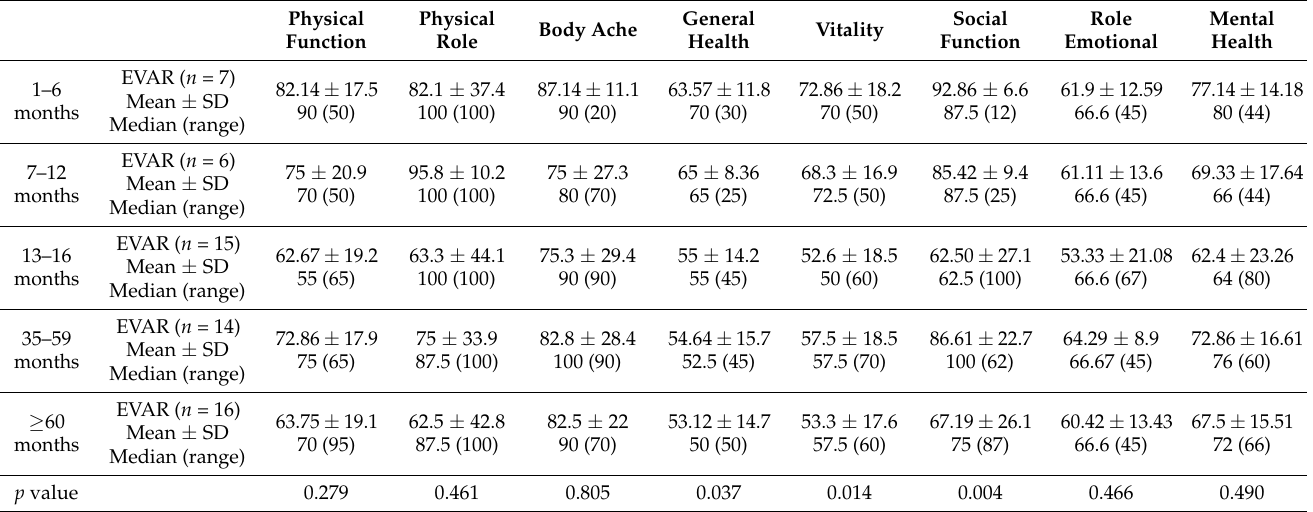
Table 4. Scores obtained on the health scales of the SF-36 Questionnaire in the EVAR group of patients according to the time elapsed since the intervention. Endoprosthesis abdominal repair (EVAR).